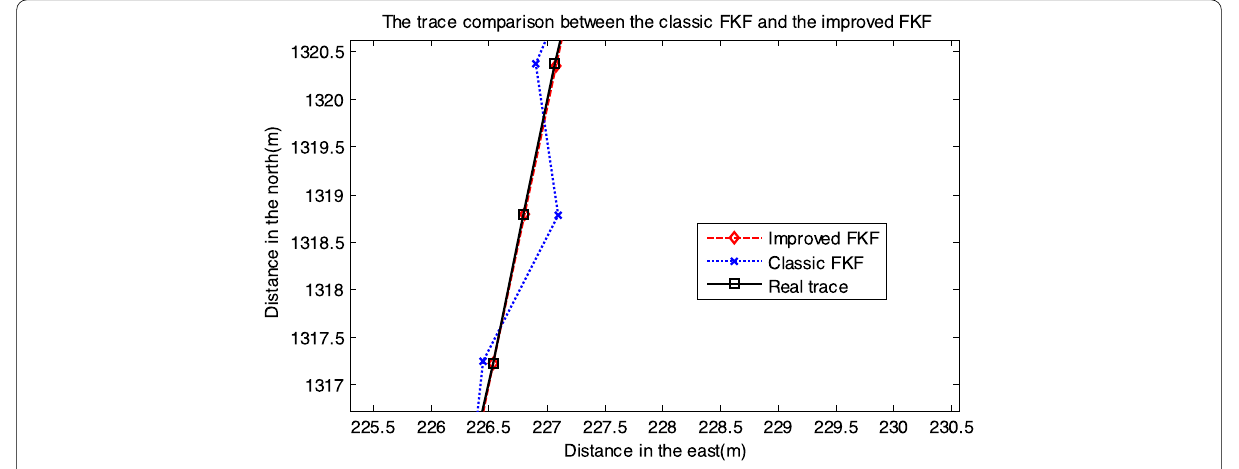
Fig. 11 The performance comparison of the two